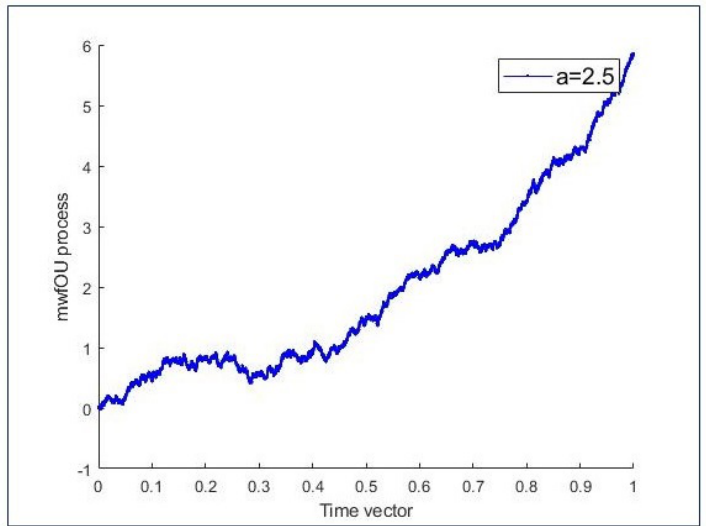
Figure 1. Simulation of sample paths of mwfOU process for large parameter values.